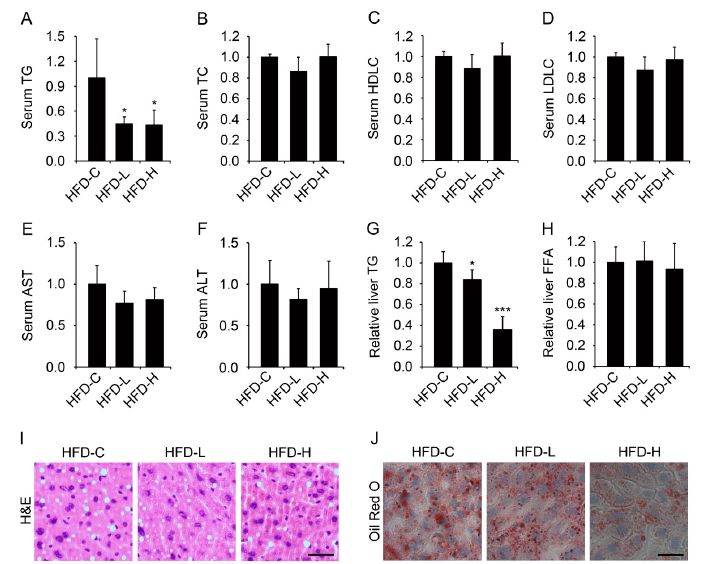
Figure 5. Hemin treatment downregulates serum triglyceride and attenuates hepatic steatosis in mice fed HFD. Mice were fed HFD (HFD-C) or HFD supplemented with hemin at a low (HFD-L) or high dose (HFD-H) for 8 weeks. Then, after fasted for 16 h, serum and liver samples were collected to measure serum triglyceride (TG) ( A ), serum total cholesterol (TC) ( B ), serum high-density lipoprotein cholesterol (HDLC) ( C ), serum low-density lipoprotein cholesterol (LDLC) ( D ), serum aspartate transaminase (AST) ( E ), alanine transaminase (ALT) ( F ), liver TG ( G ) and free fatty acid ( H ), or for hematoxylin and eosin staining ( I ) and oil red staining ( J ). Scale bar, 30 μ m. * p < 0.05; *** p < 0.001 versus HFD-C. n = 4–6 for each group.